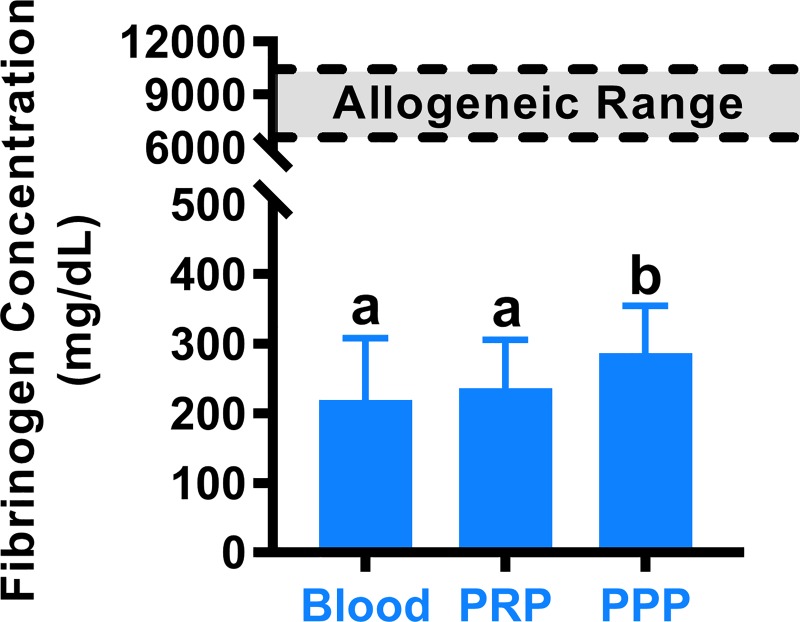
Fibrinogen concentrations for autologous sources.Fibrinogen sources with different letters were statistically different. Reported concentration range for the allogeneic fibrinogen source (Tisseel) was 6,700–10,600 mg/dL and is represented by shaded bar on graph.